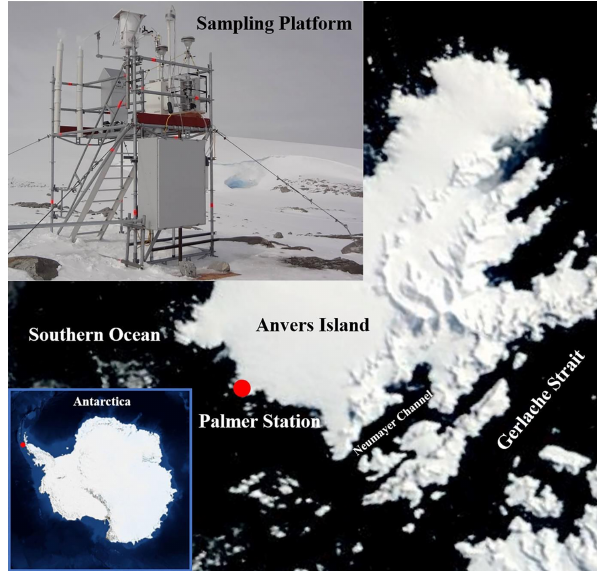
Figure 1. Sampling site at Palmer Station (red dot) with inset photo- graph of sampling platform (Gao et al., 2020) (satellite image cred- its: